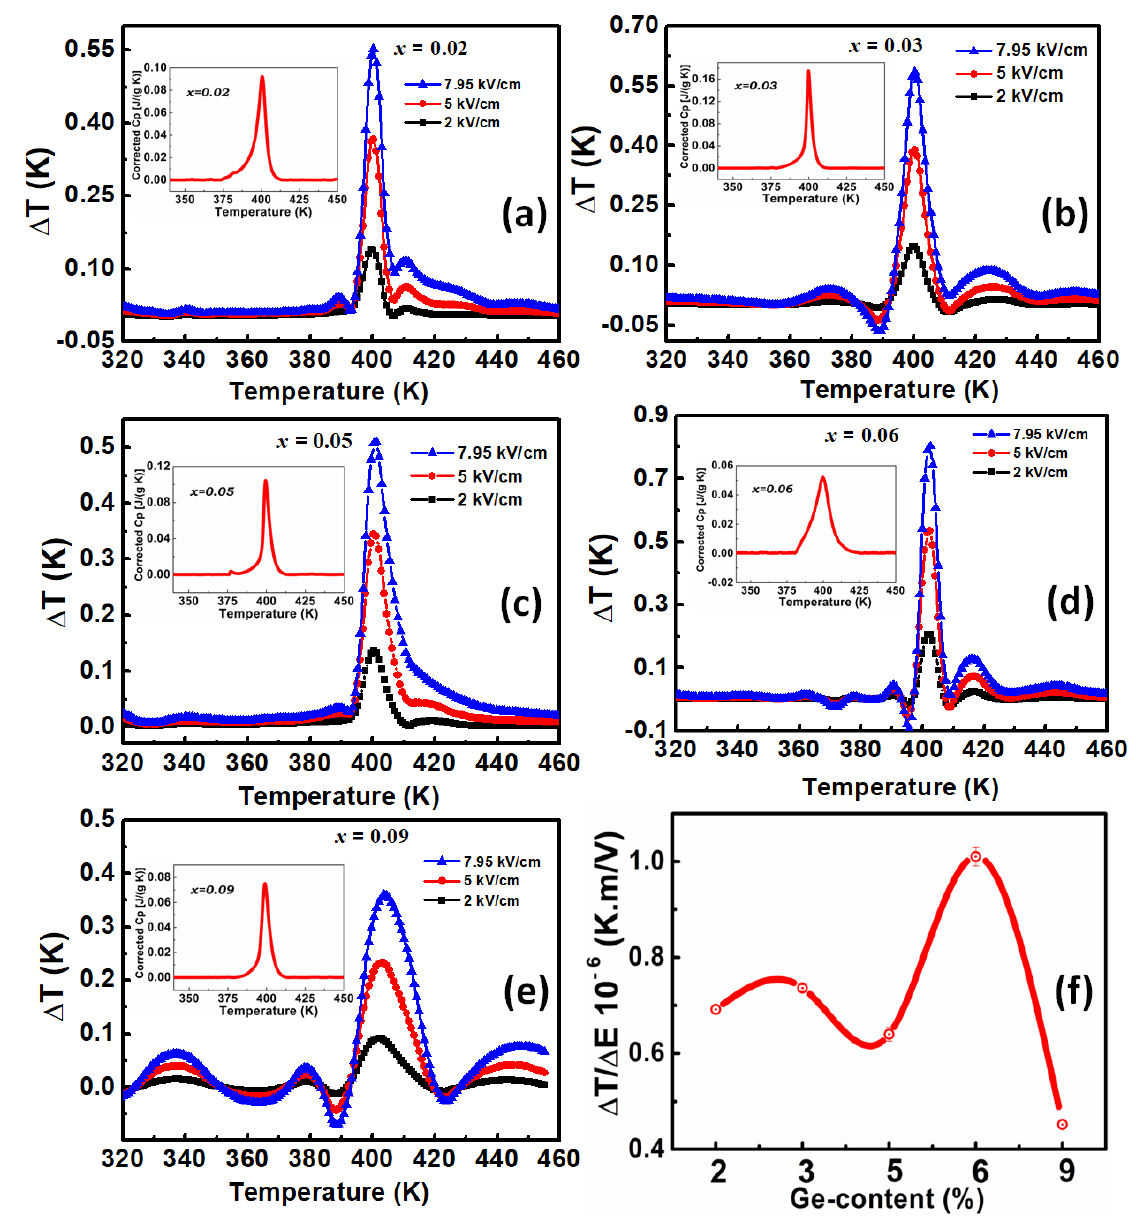
Figure 8. ( a – e ) Electrocaloric adiabatic temperature change ( ∆ T) as a function of temperature at three different applied electric fields (2.00, 5.00 and 7.95 kV/cm). The insets show corrected heat capacity Cp deduced from heat flow measurement versus temperature. ( f ) Electrocaloric responsivity as a function of Ge-content.